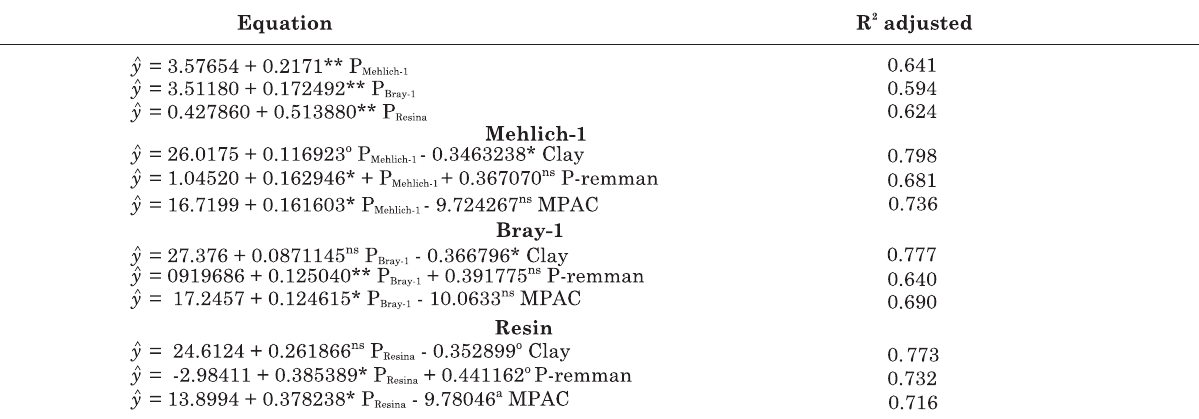
ns , a , °, * and **: non-significant, significant at 12;10;5 and 1 %, respectively.